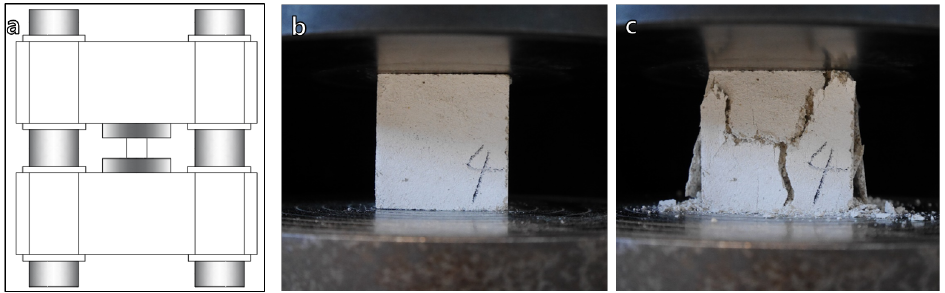
Figure 10. Mortar compression test ( a ) setup for the compression test of mortar ( b ) before testing, ( c ) after testing.